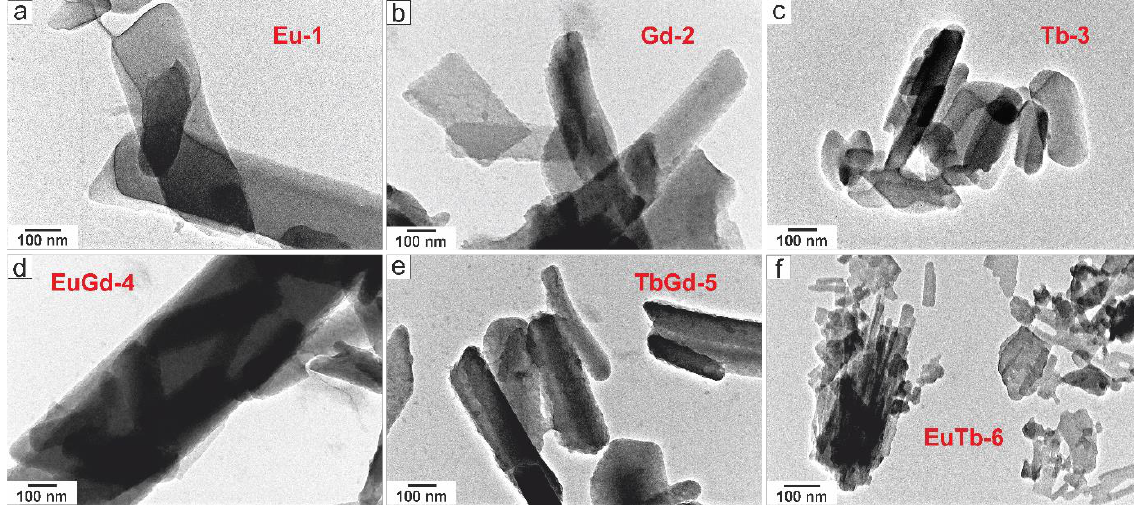
Figure 5. TEM images of the LnMOF powders: ( a ) Eu-1, ( b ) Gd-2, ( c ) Tb-3, ( d ) EuGd-4, ( e ) TbGd-5 and ( f ) EuTb-6. Table 1. The variation in sizes of the nanorods obtained from the TEM images (Figure 5). Size of Nanorod (nm) Size of Included Particles (nm) LnMOF Length Width